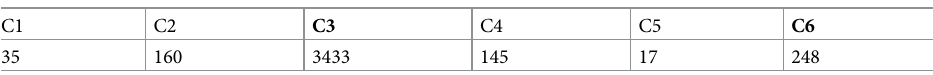
Table 3. Characterization of the clusters in group 1.